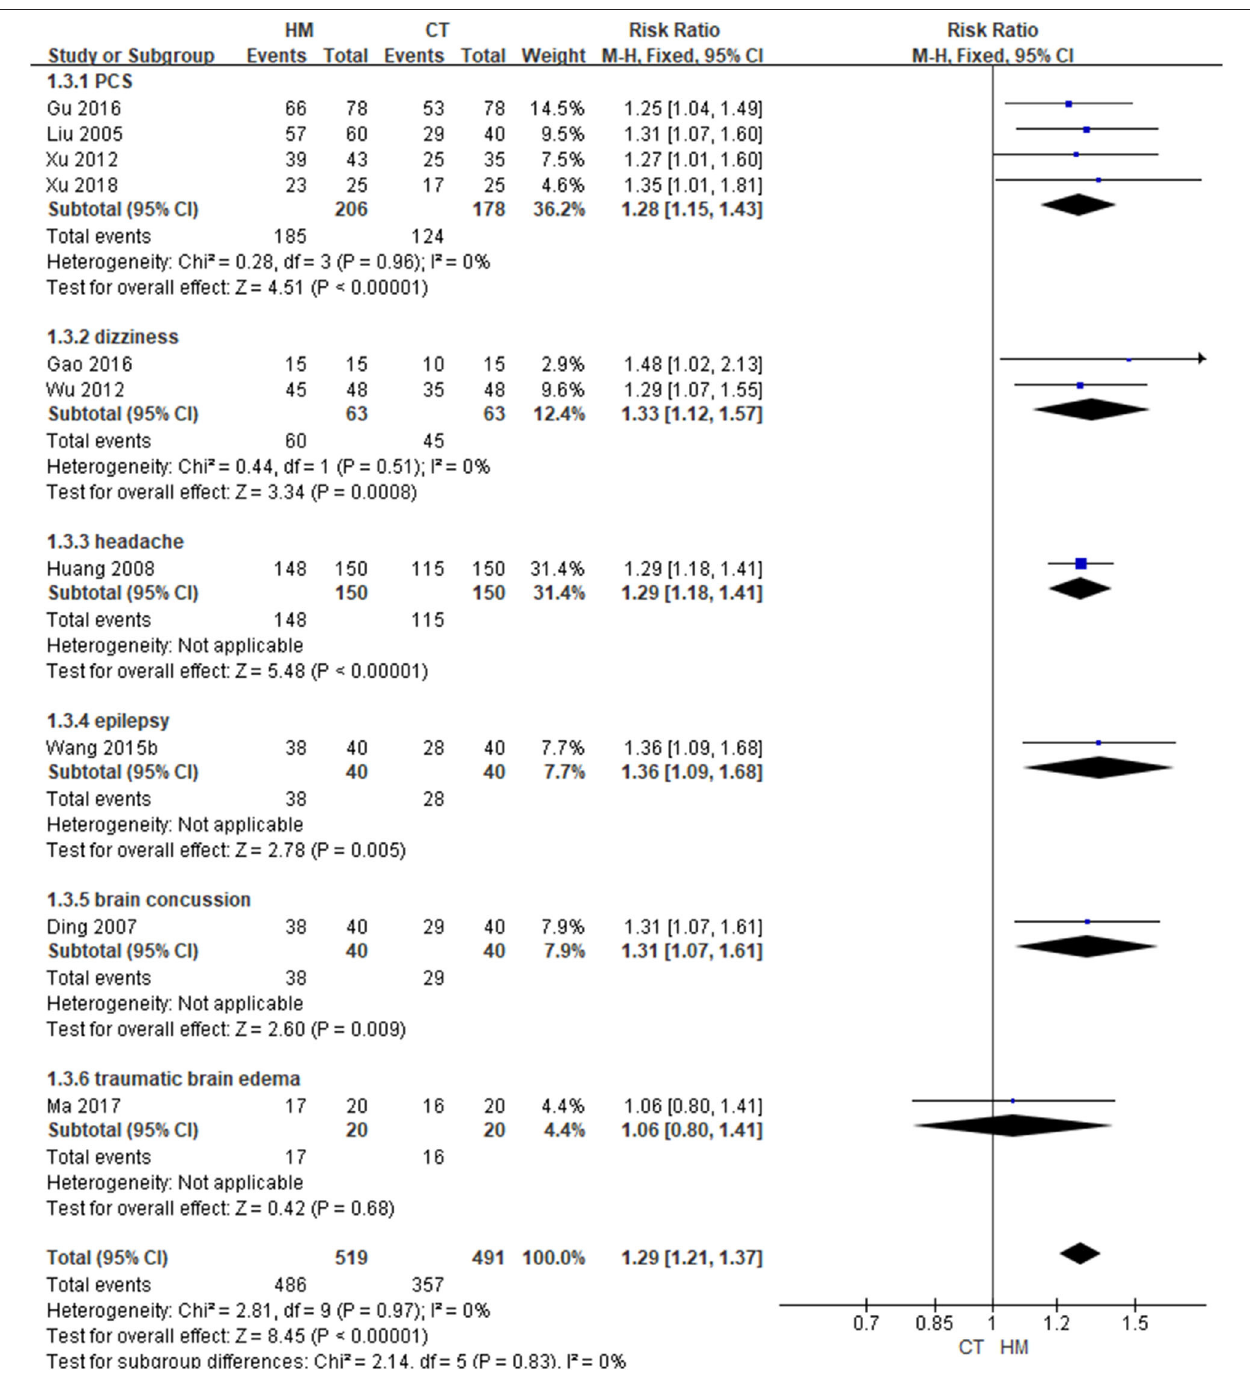
FIGURE 4 | Total Effective rate based on clinical symptoms (Comparison of herbal medicine vs. conventional treatment).